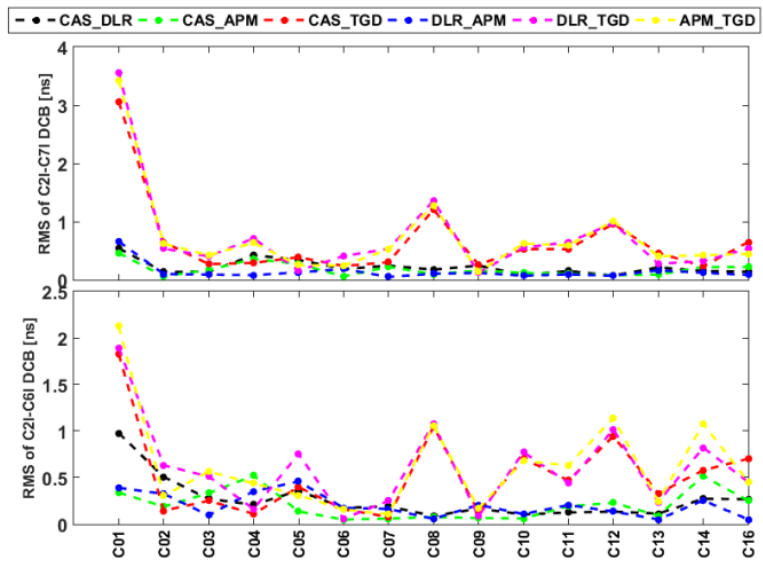
Figure 6. RMS time series of the differences in BDS-based C2I-C6I and C2I-C7I DCB estimates be- tween different solutions during the period of DOY 091–103 in 2020.